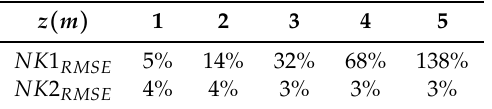
Table 4. Normalized RMSE between the true K 1, true , K 2, true and the biased K 1 , K 2 , due to an